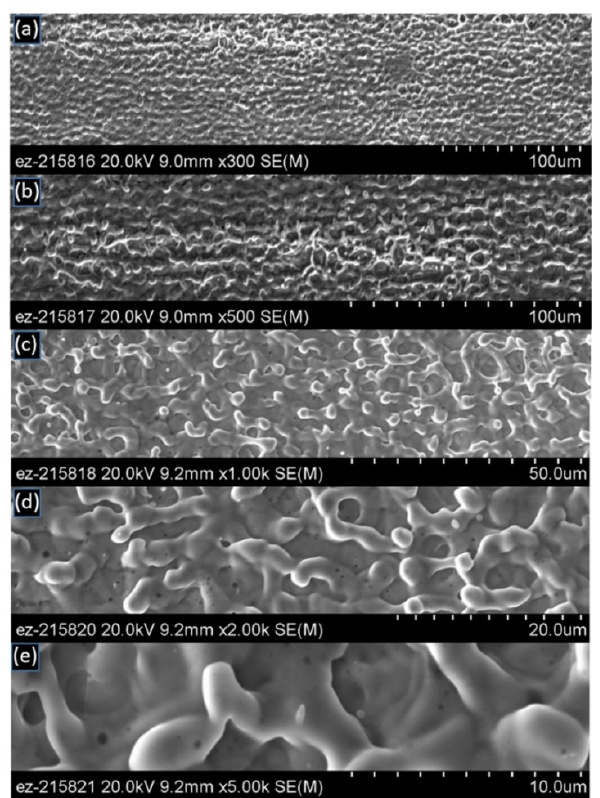
Figure 8. SEM micrographs of the laser-interference processed Cu surface (spot-by-spot method) with a 4 mm spot size and two pulses per spot at different magnifications: ( a ) 300×, ( b ) 500×, ( c ) 1000×, ( d ) 2000×, ( e ) 5000×.